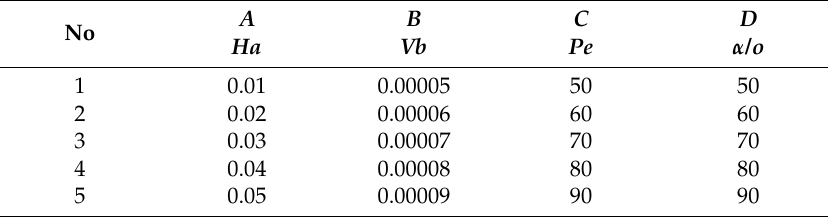
Table 1. Parameter table of four factors with five levels.